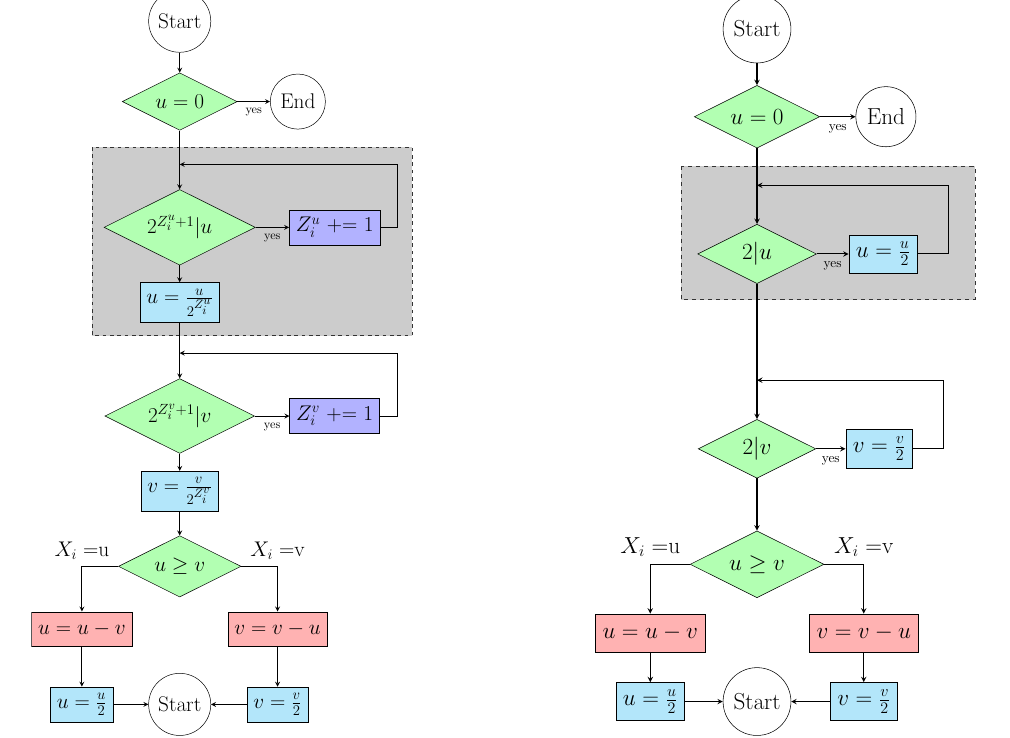
Figure 1: Binary GCD algorithm variant flowcharts. Left: mbedTLS. Right: